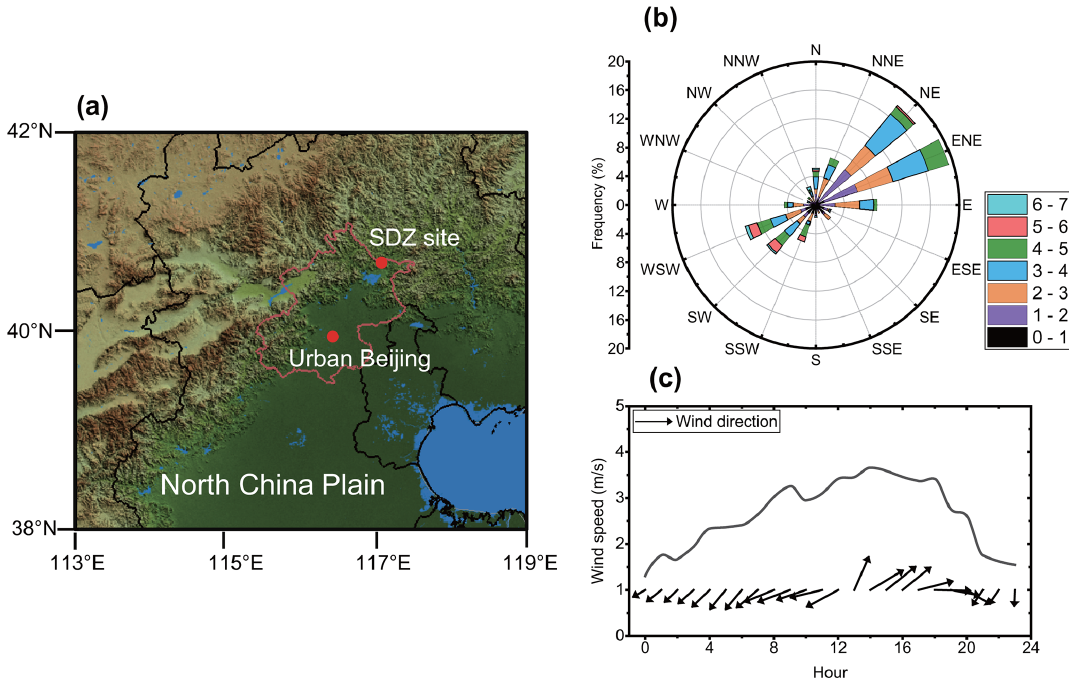
Figure 1. (a) Locations of the SDZ site, urban Beijing, and North China Plain. (b) Averaged wind frequencies (percent) and (c) diurnal wind variations during the observation period at the SDZ